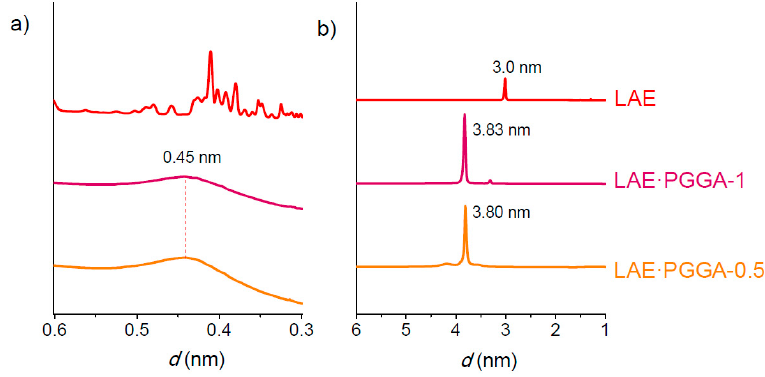
Figure 5. XRD profiles recorded from LAE and its complexes with PGGA in the wide-angle region (WAXS) ( a ) and small angle regions (SAXS) ( b ) at room temperature.